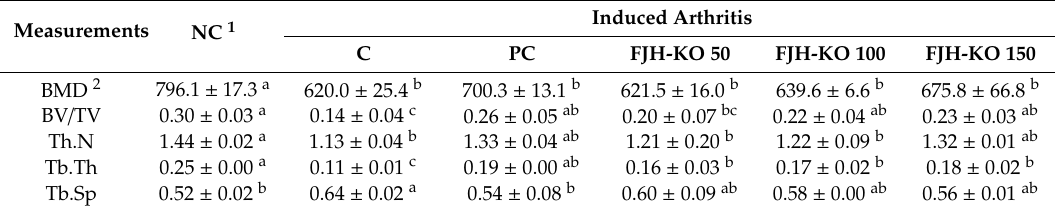
Table 2. Morphological parameters of cortical bone.